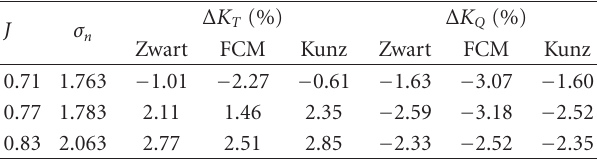
Table 4: Relative percentage errors for the E779A